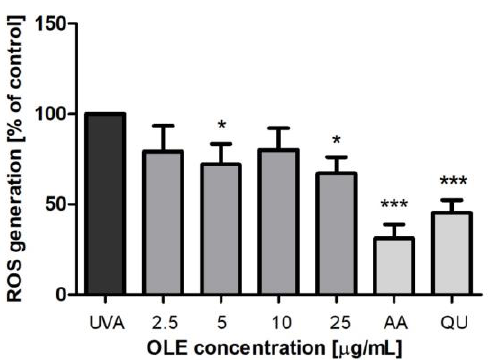
Figure 5. Changes of the intracellular ROS production in human skin fibroblasts, untreated (control) or pre-incubated (24 h) with OLE (2.5 –25 μg/mL) or reference antioxidants AA and QU (25 μg/mL) followed by exposure to UVA (8 J/cm 2 ). The figure shows mean results from 5 independent experi- ments. Error bars denote ± SD. * p < 0.05; *** p < 0.001 compared to cells irradiated in the absence of OLE (UVA).